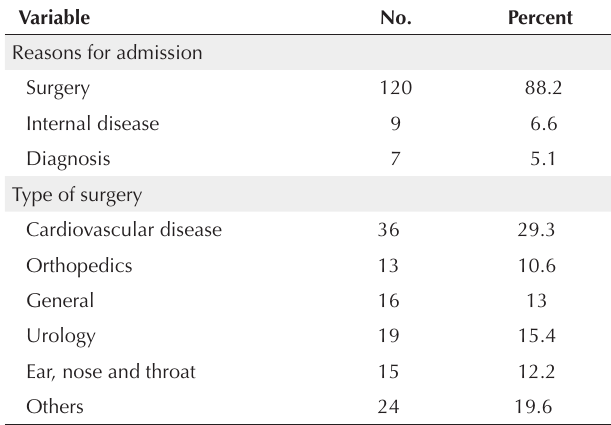
Table 1. Reasons for the Visit and Type of Surgery